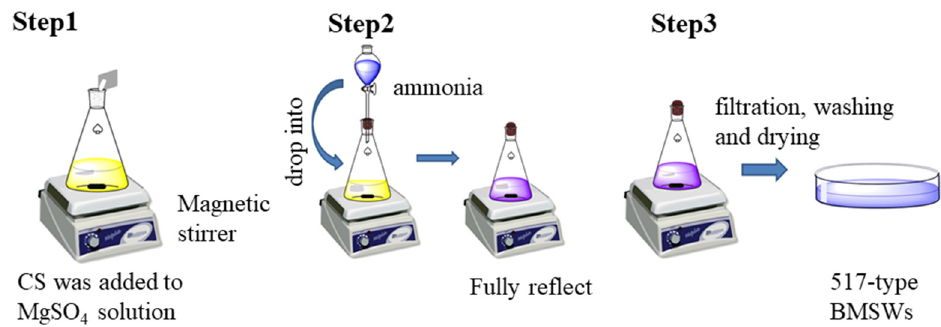
Figure 1. Preparation process of 517-type BMSWs.